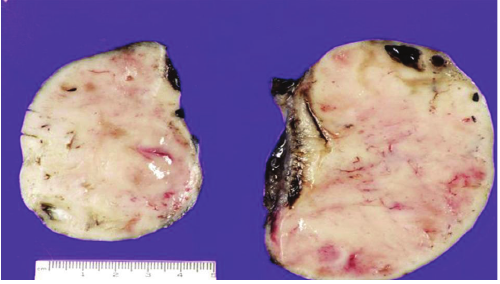
Figure 1: Sectioned right and left ovaries, with near-total obliter- ation of the usual follicular cut surface, replaced by the typical tan white appearance of lymphoma.